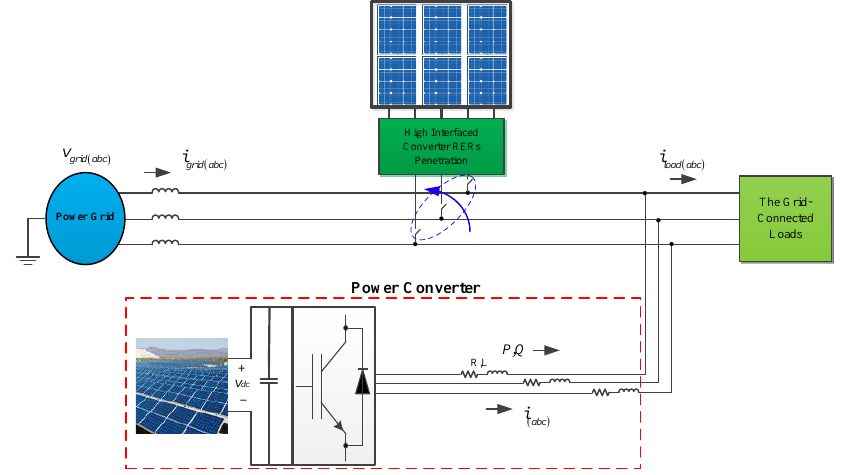
Figure 1. General structure of the proposed model.